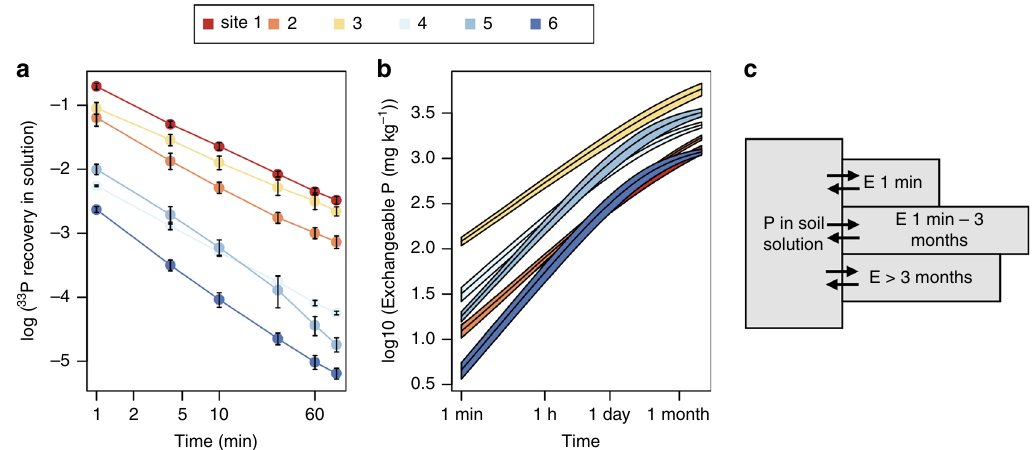
Fig. 2 Radioisotope dilution and P exchangeability. The fraction of 33 P recovered in the soil solution in minutes after addition r ( t )/ R ( a ). Isotopically exchangeable P ( E ( t ) ) for time spans up to 3 months was calculated as E t ð Þ ¼ P in both plots represent one standard deviation of four values. Conceptual representation of how E ( t ) is divided into time-dependent isotopically exchangeable P pools ( c ). Sites 1 – 6 have mean annual precipitations of 275, 316, 1340, 1578, 2163, and 3123 mm yr – 1 ,